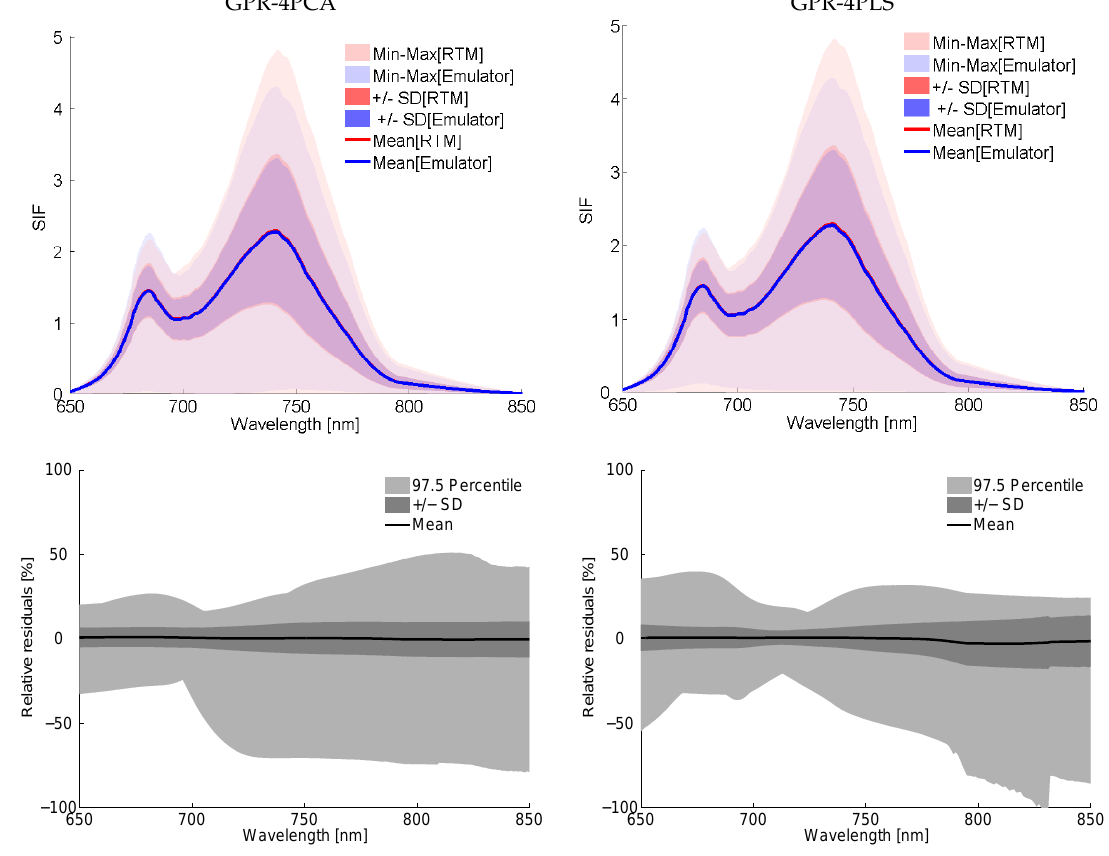
Figure 8. Top : General statistics (mean, standard deviation (SD), min-max) for SCOPE validation and corresponding emulated SIF spectra using SCOPE500-GPR-4PCA (left) and SCOPE500-GPR-4PLS (right) emulators. The SD and min-max boundaries areas are presented as semi transparent so that their shapes for both datasets can be distinguished (red: RTM, blue: emulator). Consequently, the blended purple (SD) and pink (min-max) colors indicate the degree of RTM vs. emulated data overlapping. Bottom : Relative residuals between SCOPE and emulated SIF spectra. The areas represent the maximal spectral difference (light gray) and 1 standard deviation (dark gray) for the 97.5 percentile. The black line represents the mean spectral